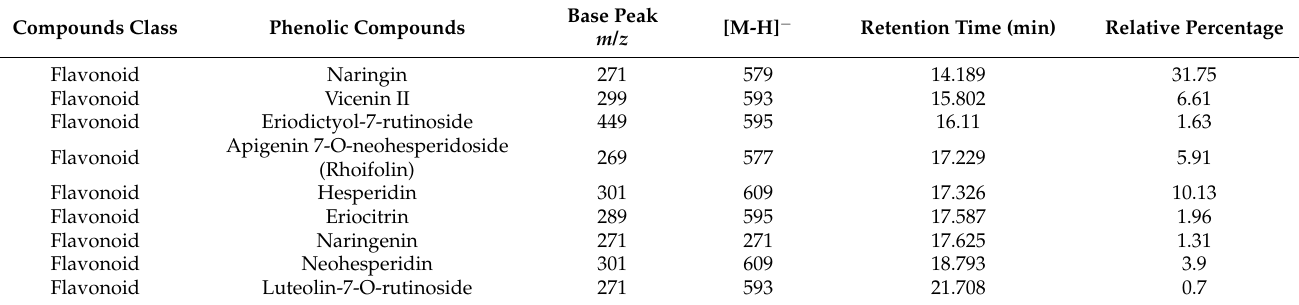
Table 6. Phenolic compounds in the C. sinensis peels by LC-MS/MS at negative ion mode. Compounds